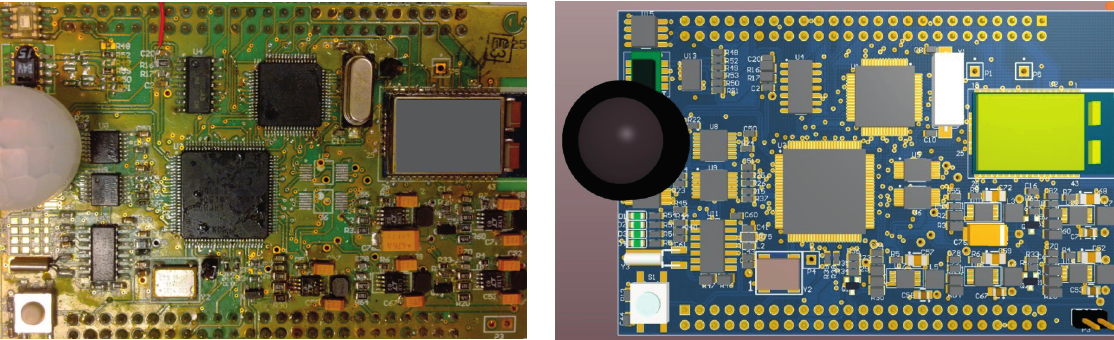
Figure 19. Prototype board of the multi-core node EMWSN.EMWSN is equipped with three microcontrollers: AVR ATmega1281, ARM AT91SAM7Sx and IGLOO nano